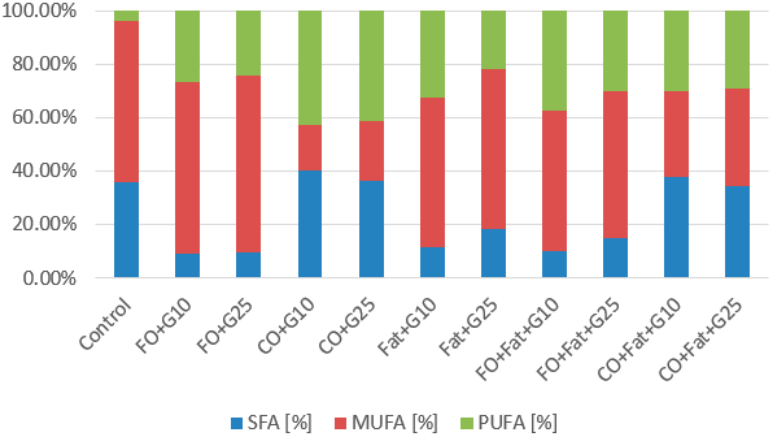
Figure 8. Phase I: Fatty acid production of Rhodotorula toruloides cultivated on a combination of waste lipids and glycerol.